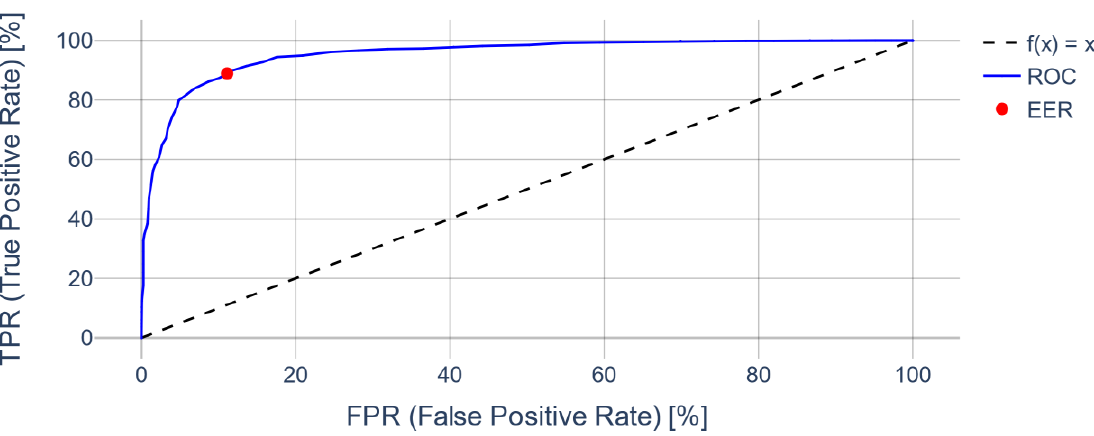
Figure 14. ROC curve for neural network evaluated on 244 signatures of 10 people containing skilled forgery attempts.